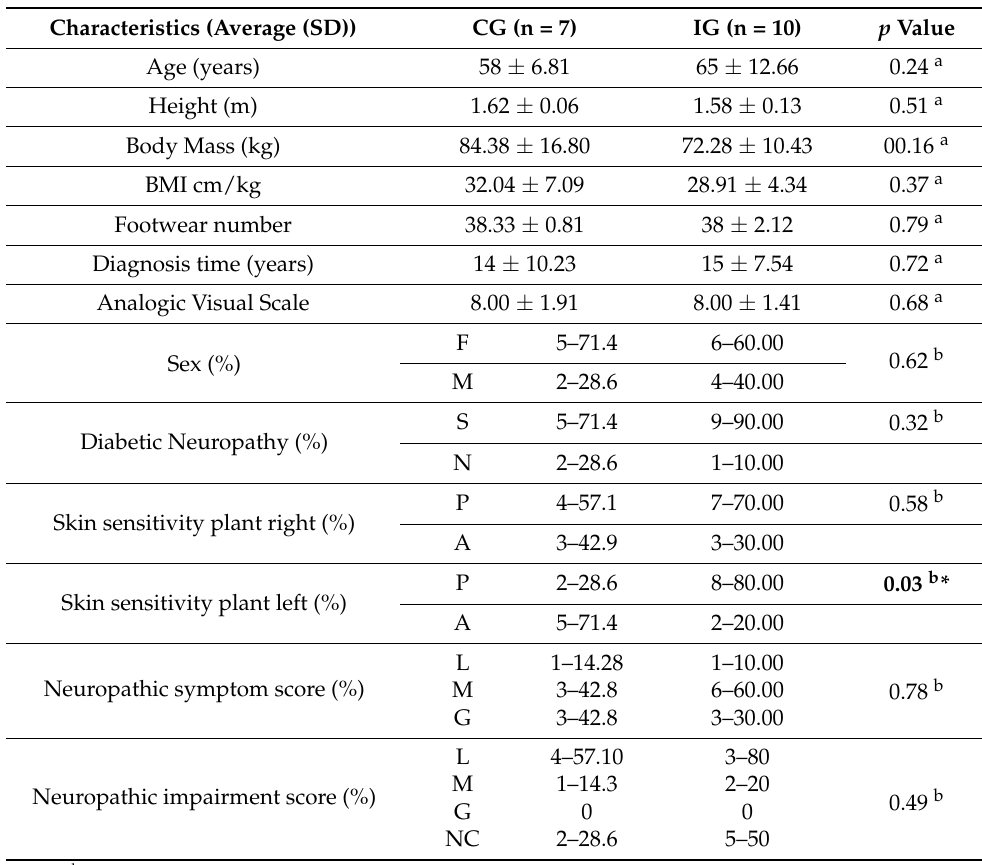
Table 1. Sociodemographic and clinical characteristics of study